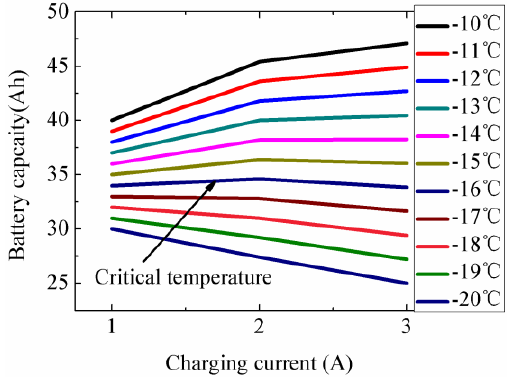
Figure 9. Discharge curves of the lead-acid battery at low temperature.